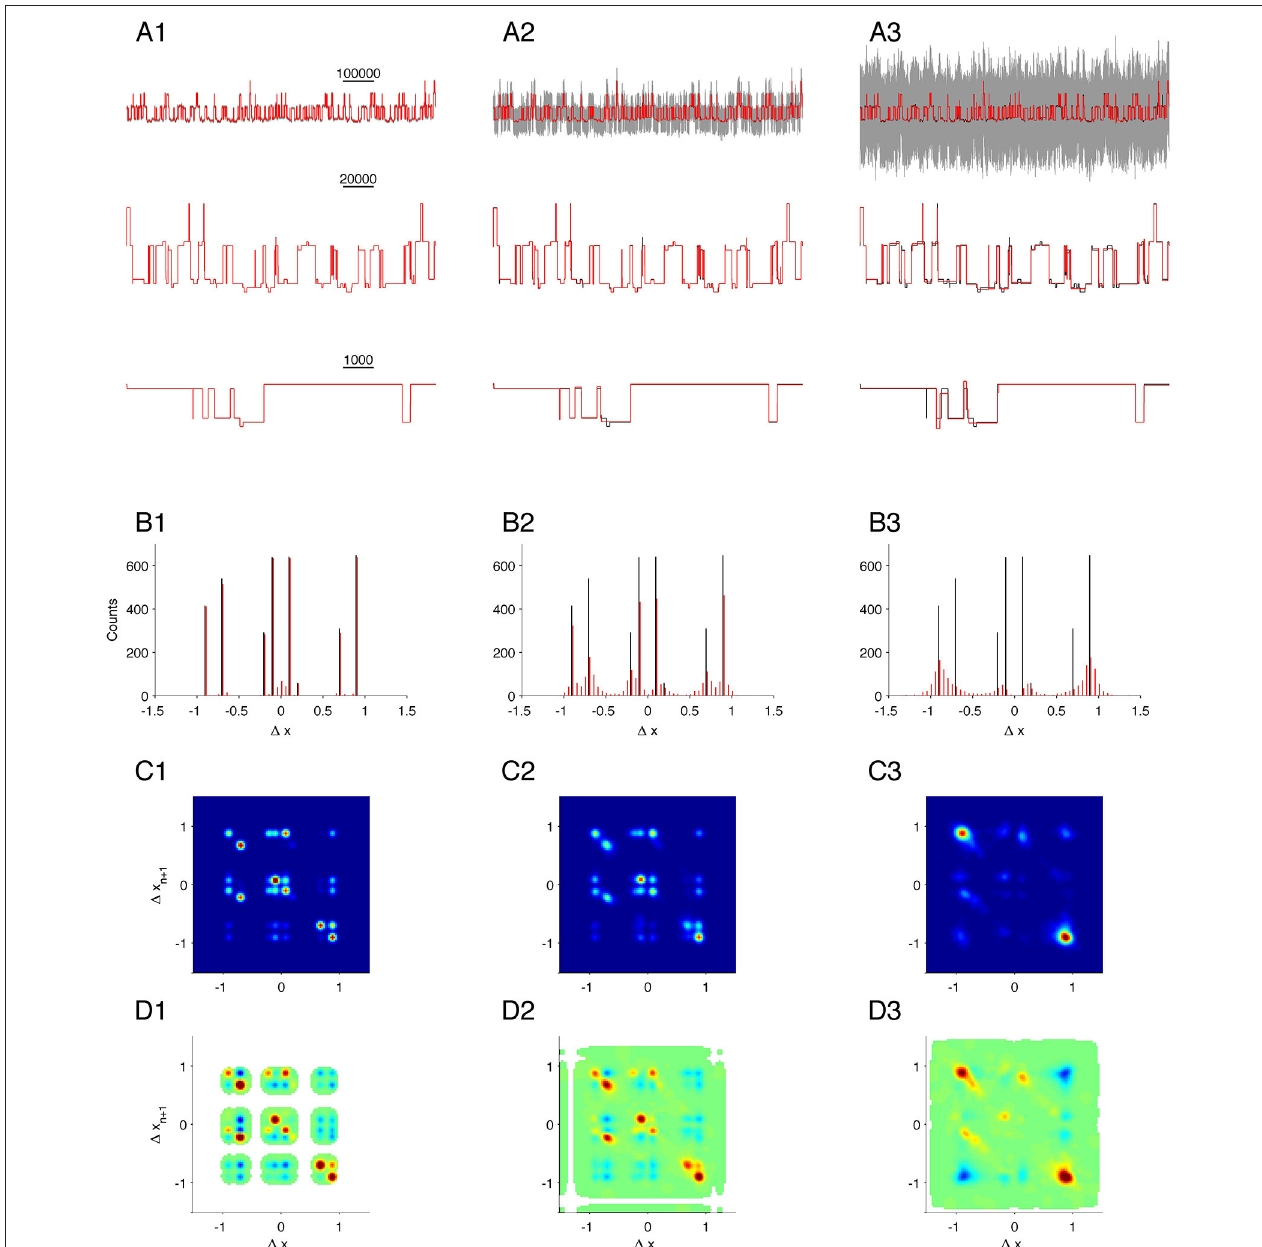
FIGURE 5 | Validation on complex simulation data with different levels of noise. Data simulates three identical, but independently operating channels. First column, (A1–D1) , is the case for low noise (SNR = 33); second column, (A2–D2) , is for medium noise (SNR = 3.3); and last column, (A3–D3) , is for high noise (SNR = 1). (A1–A3) : Gray, segment of raw data (upper line only); black, true states; red, MDL idealization. (B1–B3) : Histogram of detected steps. (C1–C3) : 2D conditional histogram of neighboring steps. (D1–D3) : Correlation between neighboring